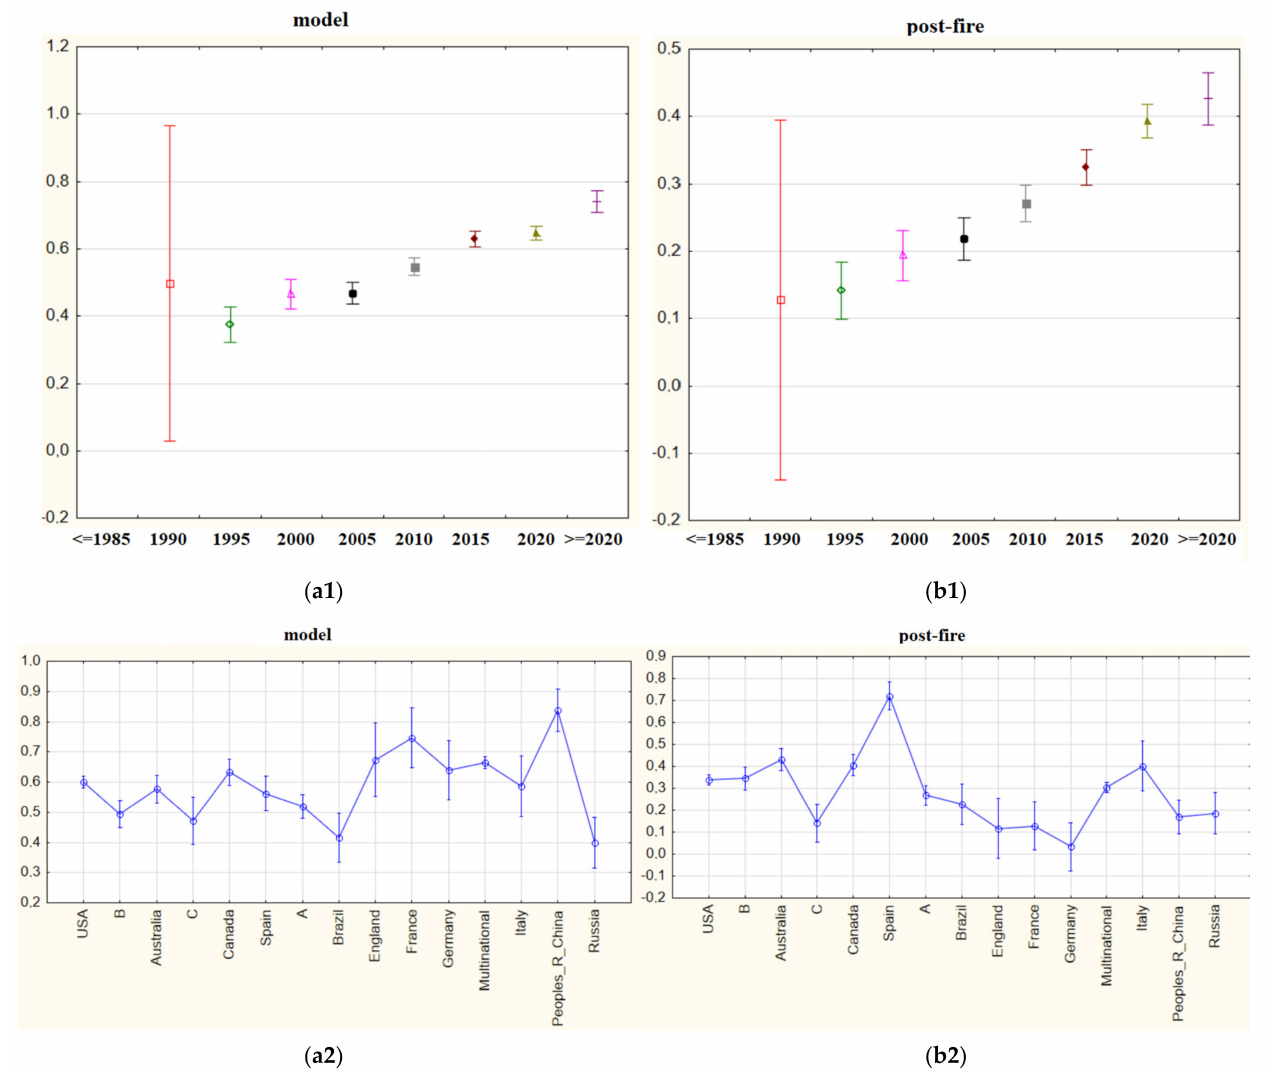
Figure 12. ( a1 ) mean importance weights of the indexed word “model” for five-year periods; ( b1 ) mean importance weights of the indexed term “post-fire” for five-year periods; ( a2 ) mean importance weights of the indexed word “model” via countries; ( b2 ) mean importance weights of the indexed term “post-fire” via